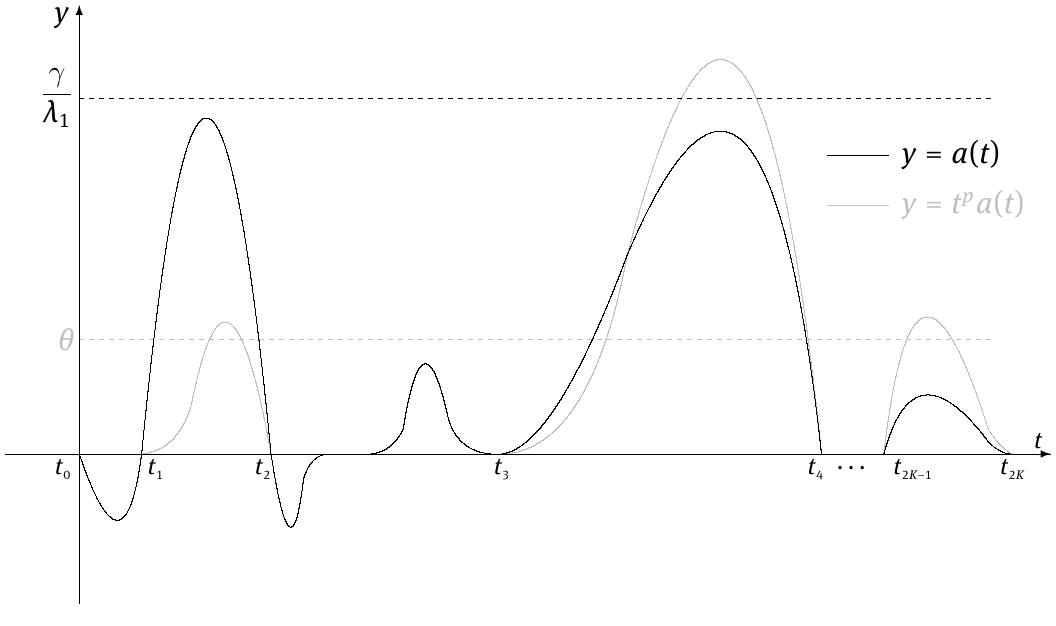
Fig. 1: Geometry of a ( t ) and t p a ( t ) satisfying ( H 1 ) , ( H 3 ) and ( H 4 )